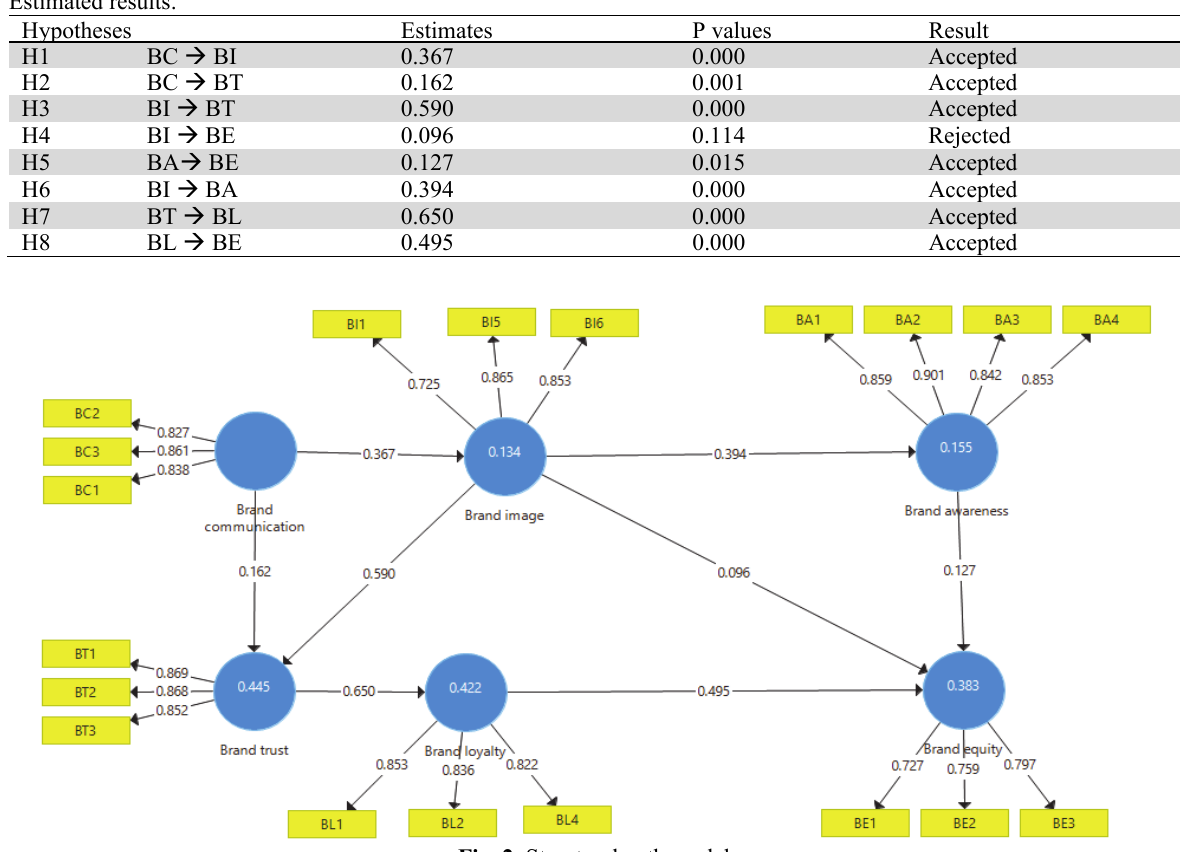
Fig. 2. Structural path